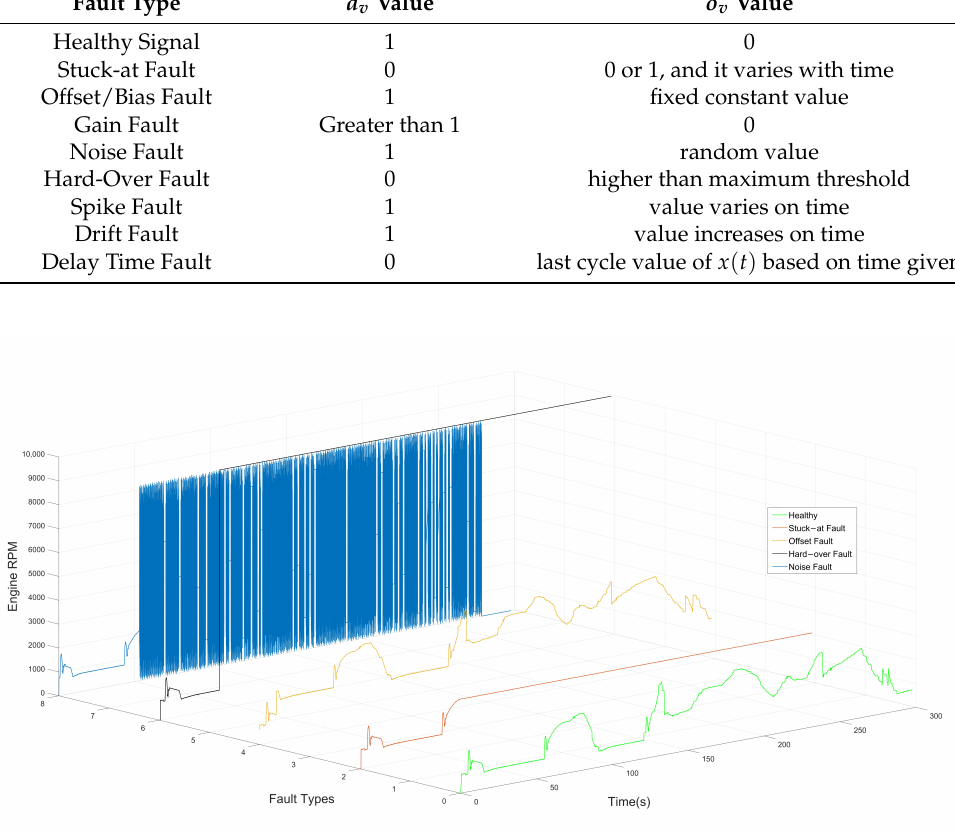
Figure 2. Healthy signal and fault types: Stuck-at fault, Offset fault, Hard-over fault, Noise